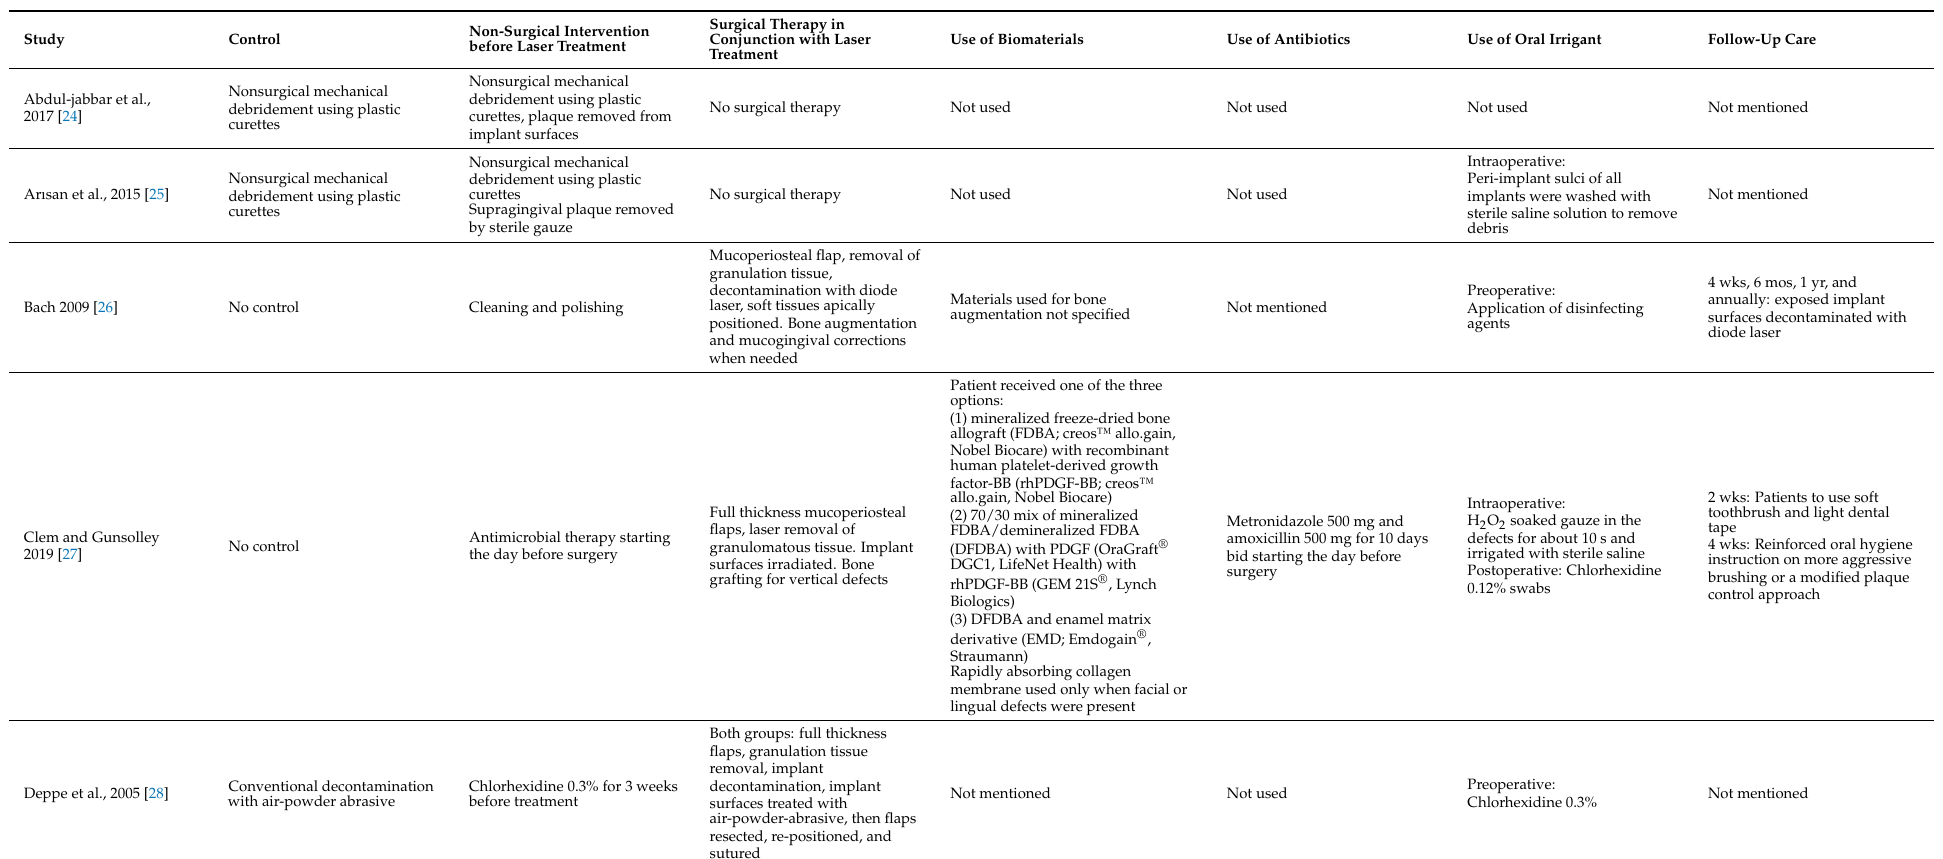
Table 4. Clinical